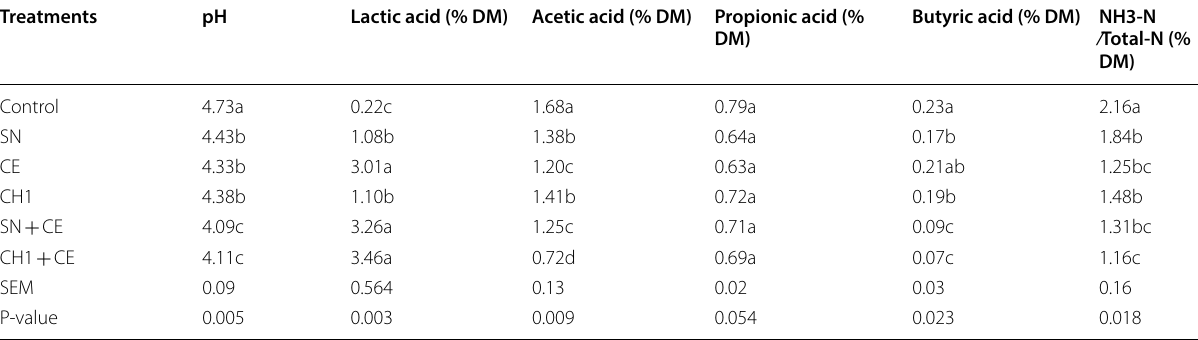
CH1, L. plantarum ; SN, L. Rhamnosus ; CE, cellulase enzyme; SN